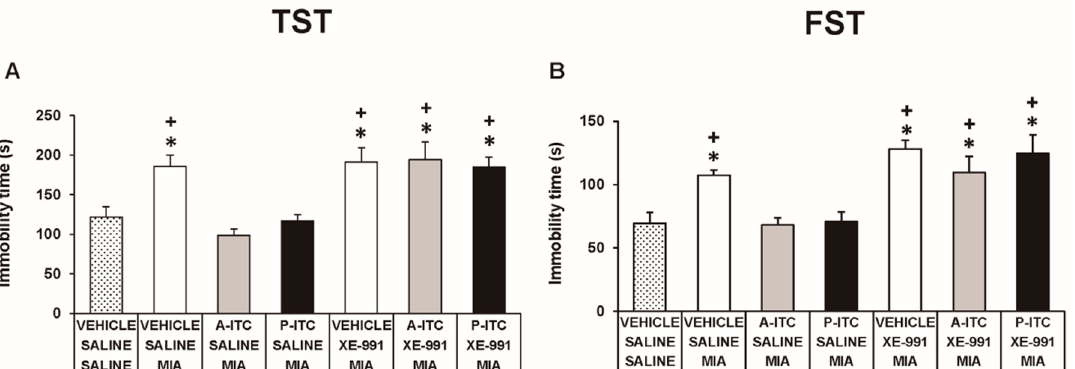
Figure 5. The administration of XE-991 reverses the inhibition of the mechanical allodynia and grip strength deficits of A-ITC and P-ITC during chronic osteoarthritis pain. The mechanical allodynia in the ipsilateral paw ( A ) and grip strength deficits in the hind paws ( B ) of the MIA-injected mice treated with A-ITC or P-ITC during 4 or 10 days alone and combined with the selective Kv7 potassium channel blocker XE-991 are shown. The effects of XE-991 administered alone are also represented. For each test evaluated, * denotes significant differences vs. saline-saline-injected mice treated with vehicle and + denotes significant differences vs. MIA saline-injected mice treated with a drug ( p < 0.05; one-way ANOVA followed by the Student–Newman–Keuls test). The results are shown as the mean values ± SEM; n = 6 animals per experimental group.